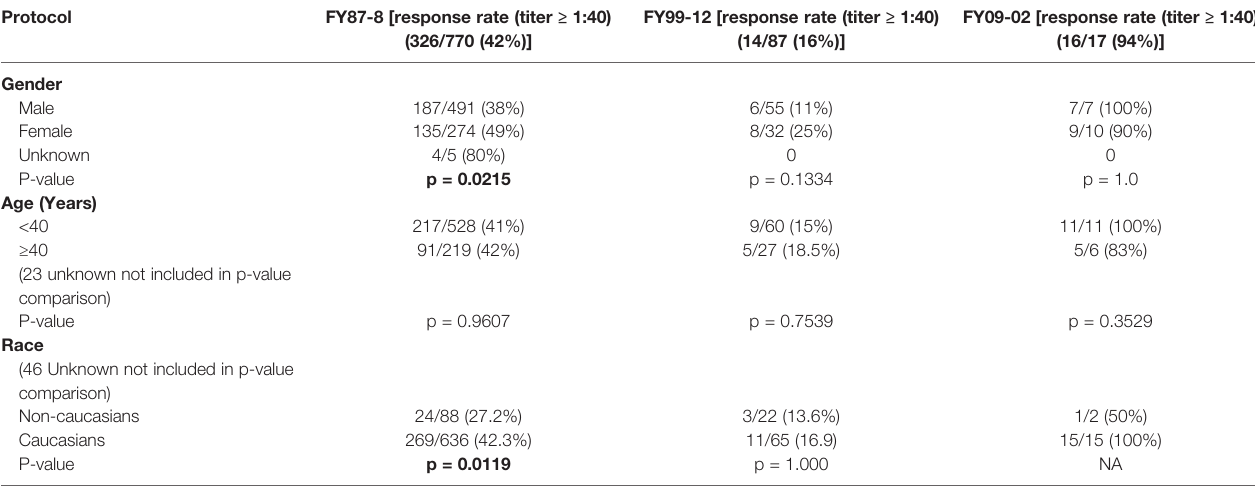
TABLE 2 | Overall response rates to WEEV following the 3 rd primary dose by subject demographics (1987 – 2011). Protocol